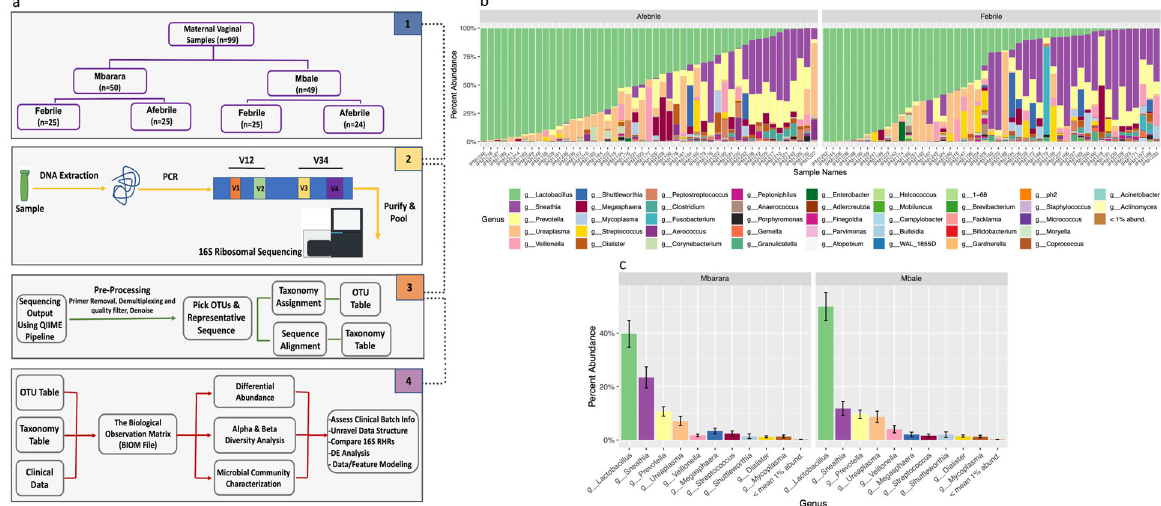
Fig. 1 Overall pipeline and structure for 16S ribosomal RNA sequencing (16S rRNA-seq) of maternal vaginal samples. a Maternal vaginal samples were collected from two hospital sites in Uganda (Mbarara and Mbale) and were categorized by intrapartum fever status. DNA was extracted and samples underwent library preparation and sequencing on two ribosomal hypervariable regions V1 – V2 and V3 – V4. The sequence output was pre-processed utilizing the QIIME1 pipeline ( “ Methods ” ) and samples were further processed for downstream differential abundance (DA) and modeling in concordance with various clinical and technical variables. b Percentage abundance of bacteria on the genus level based on the febrile status of samples. c Mean percent abundance of bacteria (agglomerated on the genus level) by enrollment site. (g_) denotes the bacteria naming based on genus taxonomic level.